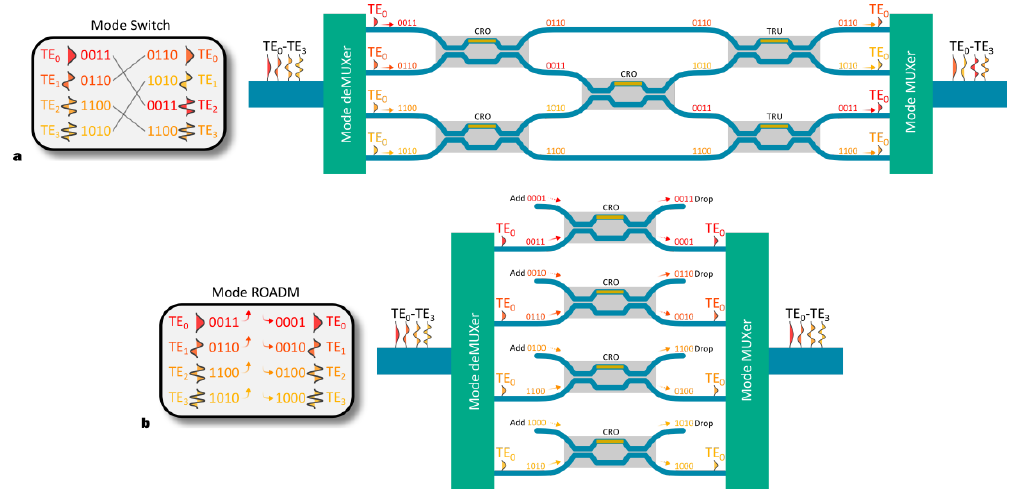
Figure 19. The configurations for ( a ) mode switch [245] and ( b ) mode reconfigurable optical add-drop multiplexers (ROADM) [250]. The insets show the mapping relation between signals and modes. Here, a four-channel MDM system is illustrated as an example.